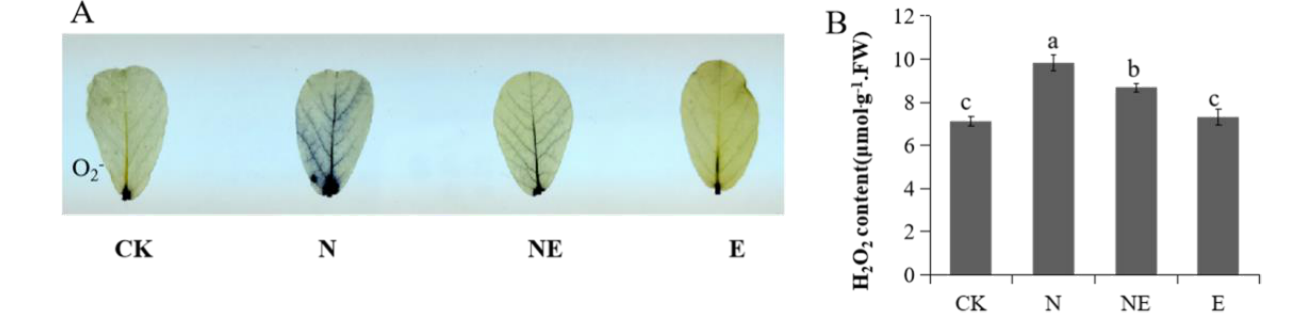
Figure 2. Effects of EBL on ROS production in peanut seedlings under NaCl stress. CK (normal conditions), N (treated with 150 mM NaCl), NE (treated with 150 mM NaCl and 0.1 µM EBL) and E (treated with 0.1 µM EBL). ( A ) NBT staining of superoxide anion; ( B ) H 2 O 2 content. Different low- ercase letters indicate significant differences between treatments ( p < 0.05).